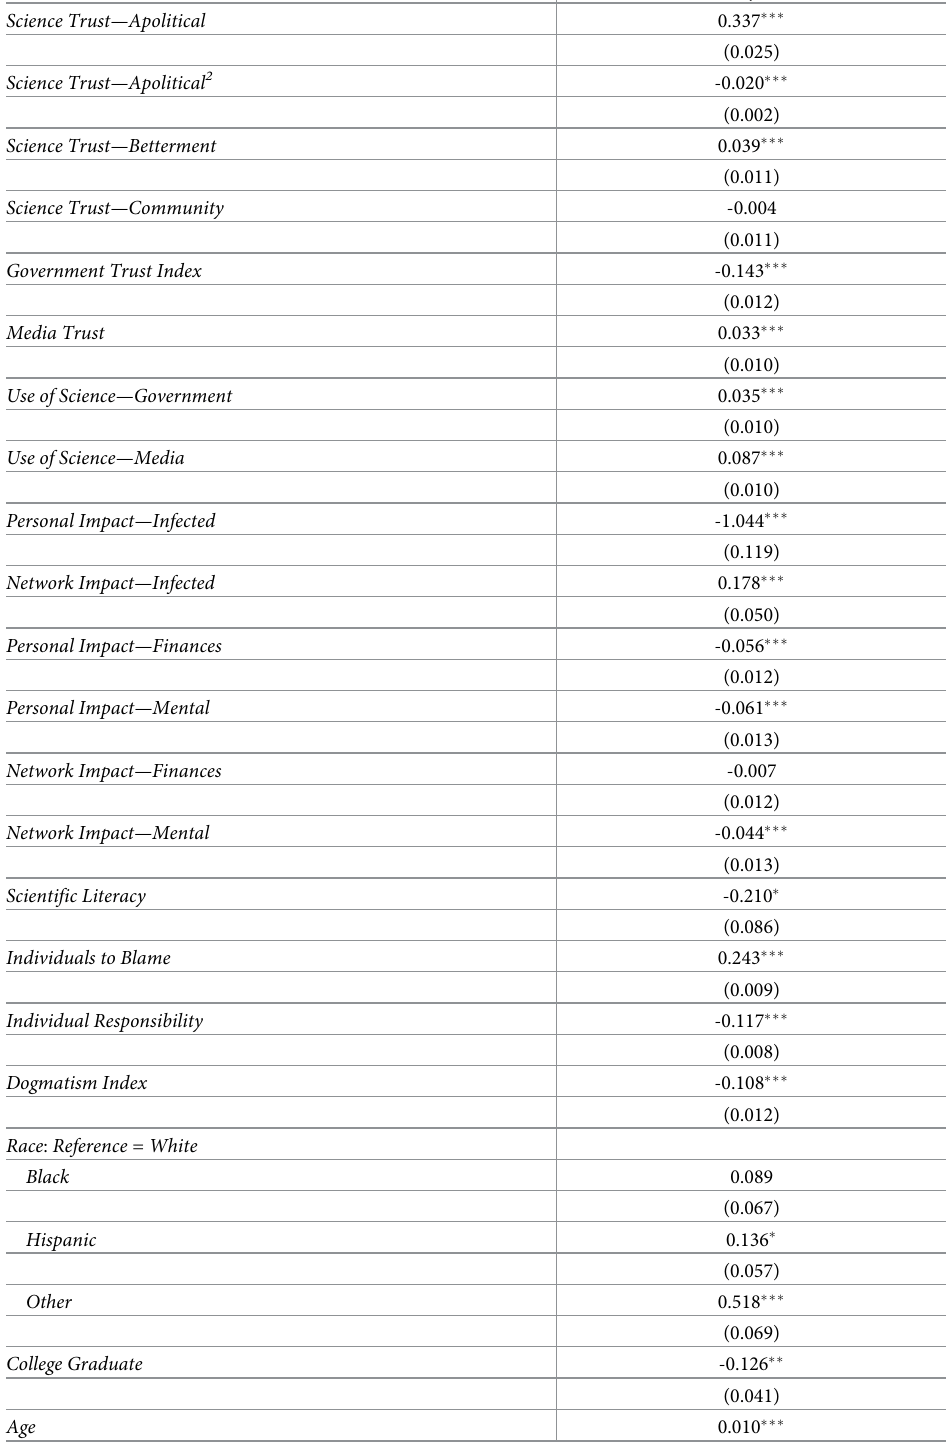
Table 1. Regression results for primary multilevel regression model and alternate model excluding the Science Trust—Apolitical 2